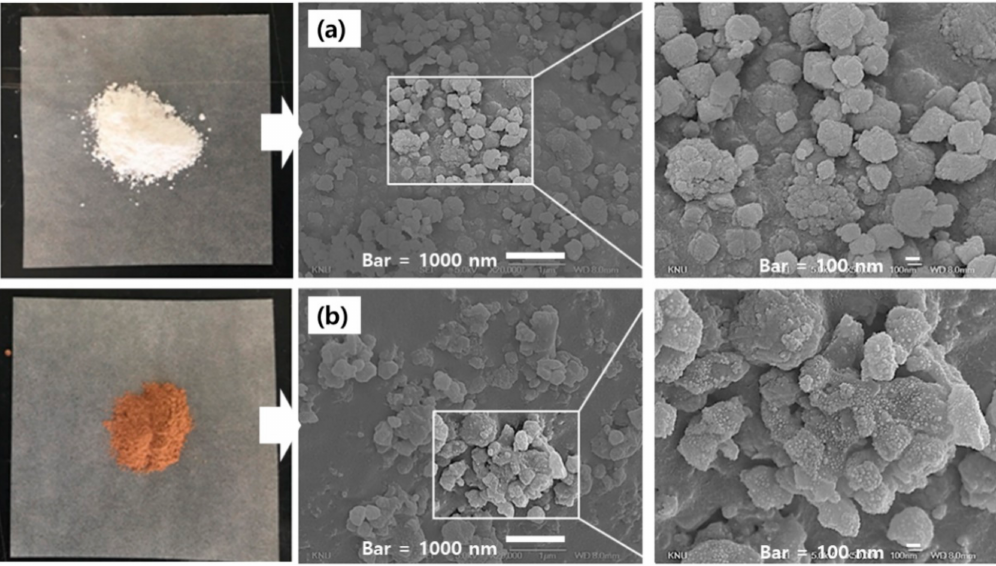
Figure 2. SEM photographs of empty zeolite nanocomposites ( a ) and propolis-embedded zeolite nanocomposites ( b